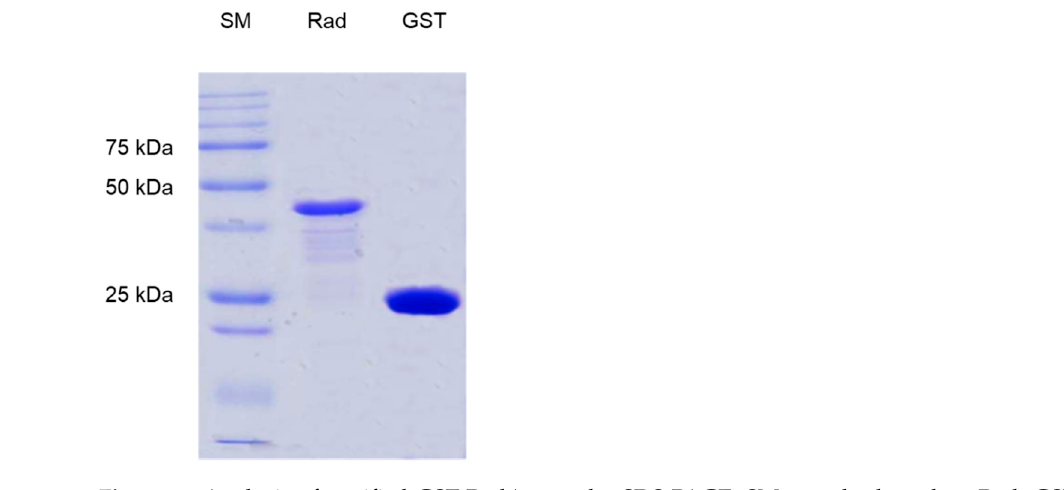
Figure 3. Analysis of purified GST-RadA 35-252 , by SDS-PAGE. SM, standard marker; Rad, GST- RadA 35-252 ; GST, glutathione S-transferase; 25 kDa, 50 kDa and 75 kDa indicate the molecular weight of three proteins present in the SM.